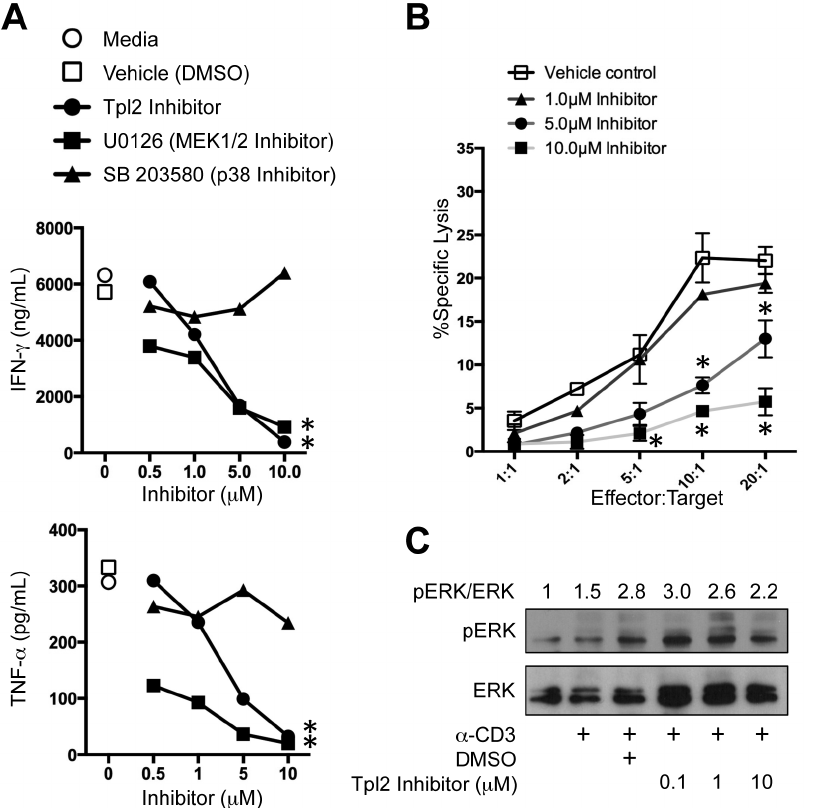
Figure 6. Pharmacological blockade of Tpl2 significantly impairs human CTL cytokine secretion and lytic activity. CD8 + CCR7 lo T EM CTLs were sorted from healthy human PBMCs. (A) Sorted cells were stimulated with plate-bound anti-CD3 and rhIL-2 (200 U/mL) 6 indicated kinase inhibitors. Supernatants were collected at 24 h post stimulation. IFN- c (top panel) and TNF- a (bottom panel) in the supernatant were measured using ELISA and mean 6 SEM is plotted for a representative of five similar experiments. (B) Sorted CD8 + CCR7 lo T EM CTLs were used in redirected lysis assay at the indicated Effector:Target ratios using anti-CD3 coated THP-1 target cells 6 Tpl2 inhibitor at the indicated concentrations. Killing of target cells is plotted as percent specific lysis, mean 6 SD plotted. Data shown are representative of two similar experiments from separate healthy adult donors. (C) Purified human CD8 + T cells were expanded for 5 days on anti-CD3/anti-CD28-coated plates in the presence of rhIL-12. Cells were rested for 24 h then restimulated with biotin-anti-CD8 + biotin-anti-CD3 with crosslinking streptavidin for 10 min in the absence or presence of the Tpl2 inhibitor at the indicated concentrations. Cell lysates were prepared and assessed for p-ERK and ERK by western blotting. Data are representative of 3 separate